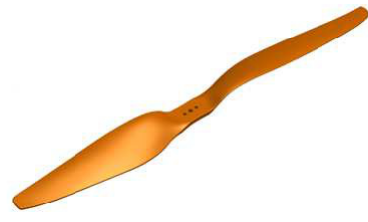
Figure 2. ARAKNOS V2 Rotor